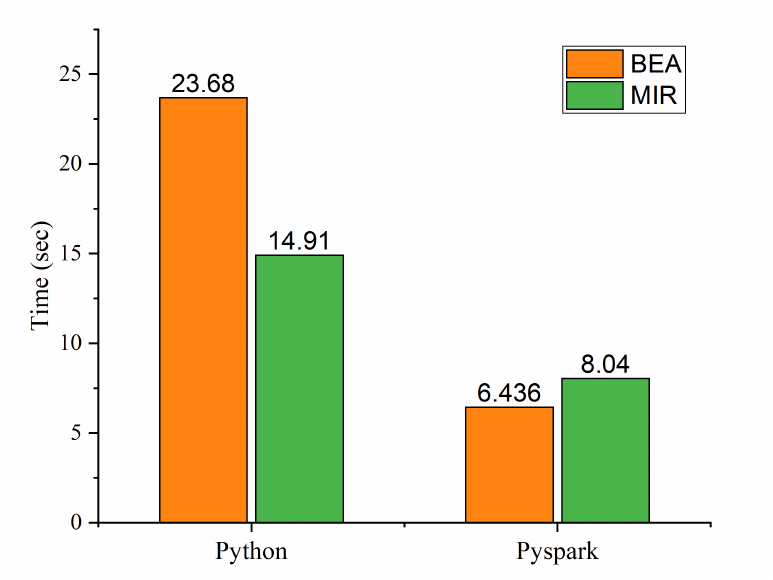
Figure 8. Execution time of MIR and brain extraction application (BEA) [30] on stand-alone